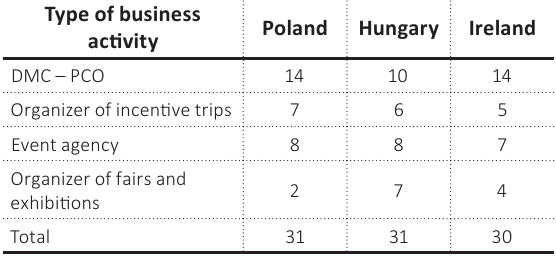
Table 2. Type of business activity – CEO